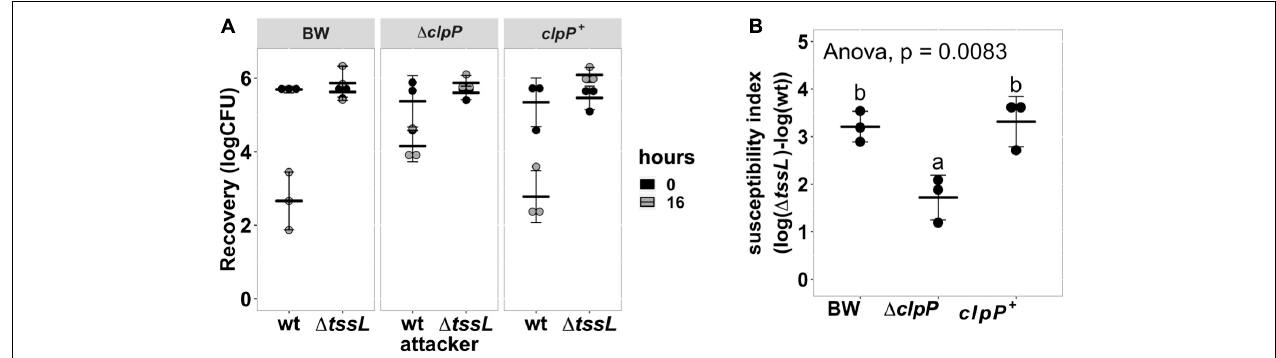
FIGURE 3 | Agrobacterium tumefaciens susceptibility to type VI secretion system (T6SS)-dependent antibacterial activity was reduced in Escherichia coli clpP:kan and can be fully complemented in trans . (A) Recovery of surviving E. coli cells at 0 h and 16 h after being co-cultured with either A. tumefaciens wild type C58 (wt) or (cid:49) tssL at a ratio of 30:1. (B) The susceptibility index (SI) of E. coli BW25113 wild type (BW), (cid:49) clpP , and (cid:49) clpP complemented with clpP expressed on plasmid ( clpP + ) was calculated from the recovery rate shown in (A) . Statistical analysis involved single-factor analysis of variance (ANOVA) and Tukey honestly significant difference (HSD). Data are mean ± SD of three independent experiments, and two groups with significant differences are indicated with different letters (a and b) ( P < 0.05 for statistical significance).